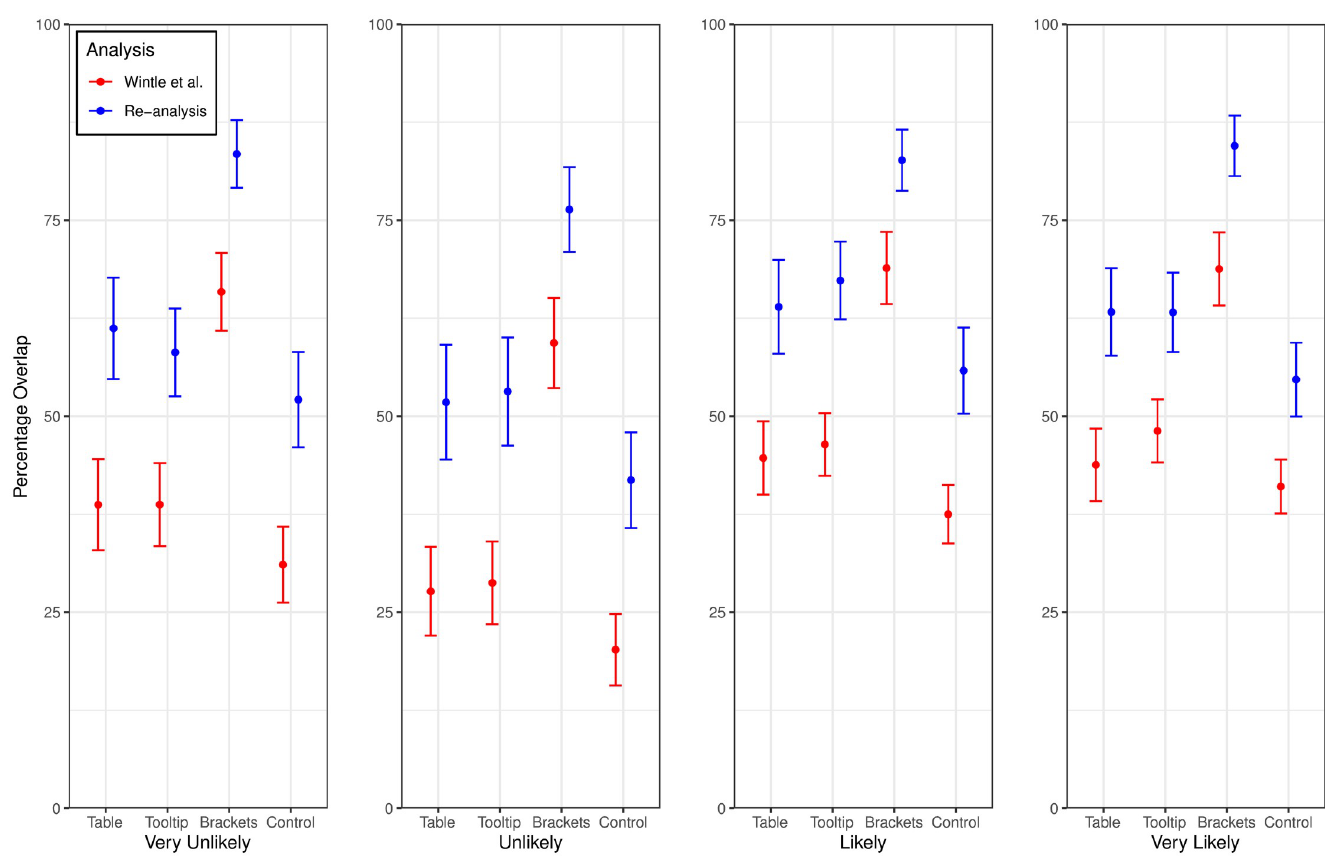
Fig 1. Mean percentage overlap (PO). Error bars show 95% confidence intervals around the means. Results are plotted as a function of presentation format (i.e., Table, Tooltip, Brackets, and Control conditions), probability term (i.e., Very Unlikely, Unlikely, Likely, and Very Likely), and analysis type ([1] in red and our re- analysis in blue).